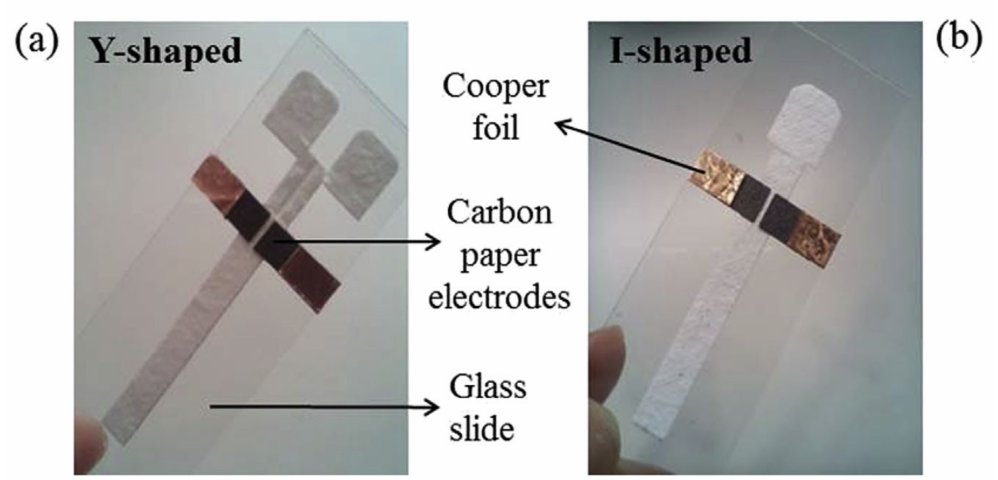
Figure 9. In detail, ( a ) represents Y-shaped paper-based fuel cell and ( b ) I-shaped paper-based fuel cell, as reported in [40]: the system is fixed on glass slides, displaying carbon paper electrodes attached to a piece of cooper foil. Reprinted from [40], with permission from